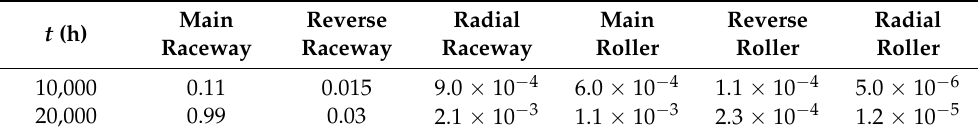
Figure 5. Load on each reserve roller. Table 3. The damage D of each part of the main bearing at di ff erent times.